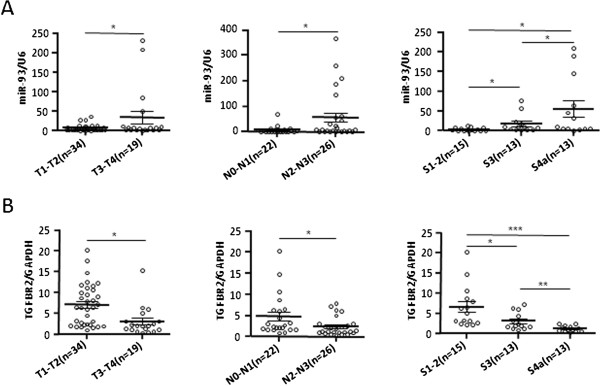
MiR-93 and TGFβR2 were clinically associated with NPC aggressiveness. (A) The detection of miR-93 expression by qRT-PCR in an additional set of primary NPC samples. As showed in the plot diagrams, the miR-93 expression was positively correlated with T, N classification and clinical staging. Values represent mean ± SD, *p < 0.05 (B) qRT-PCR analysis of TGFβR2 mRNA expression showed a negative correlation of TGFβR2 expression with T and N classifications and clinical staging in scatter plot diagrams. Values represent mean ± SD, *P < 0.05, **P < 0.01, ***P < 0.001.